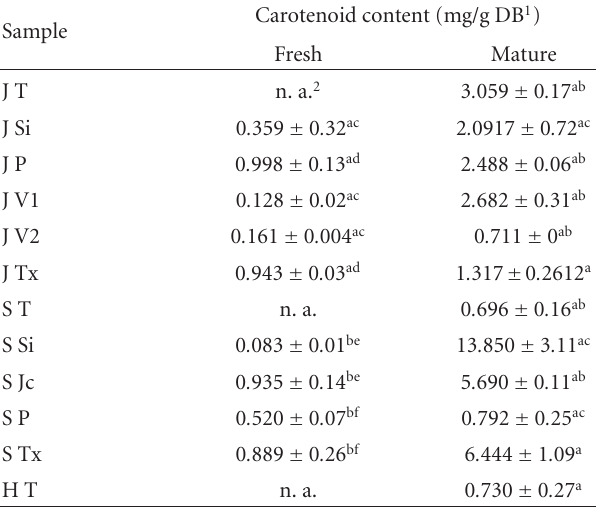
Table 3: Content of carotenoids in chilli